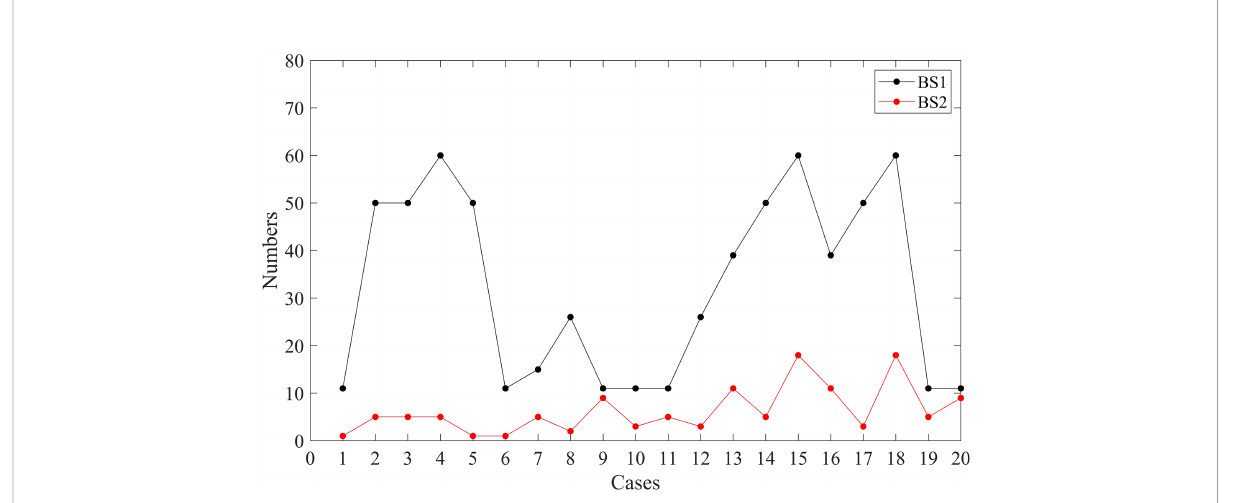
FIGURE 2 The initial block size BS1 (black dot) and the increment BS2 (red dot) of each cycle for